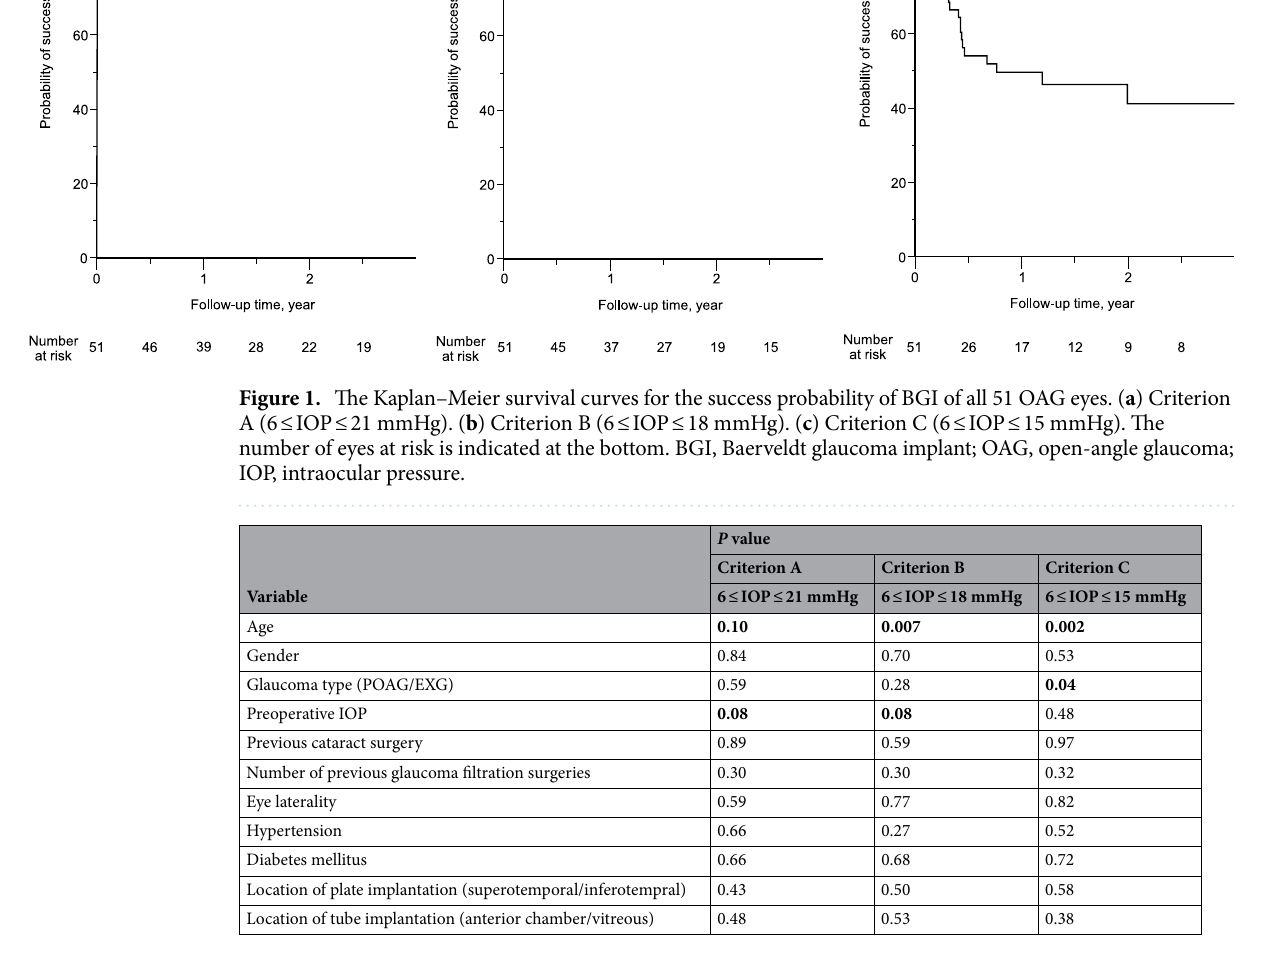
Table 2. Univariate analysis of candidate factors associated with the surgical outcomes of BGI for OAG by the Cox proportional hazards model. BGI Baerveldt glaucoma implant, OAG open-angle glaucoma,